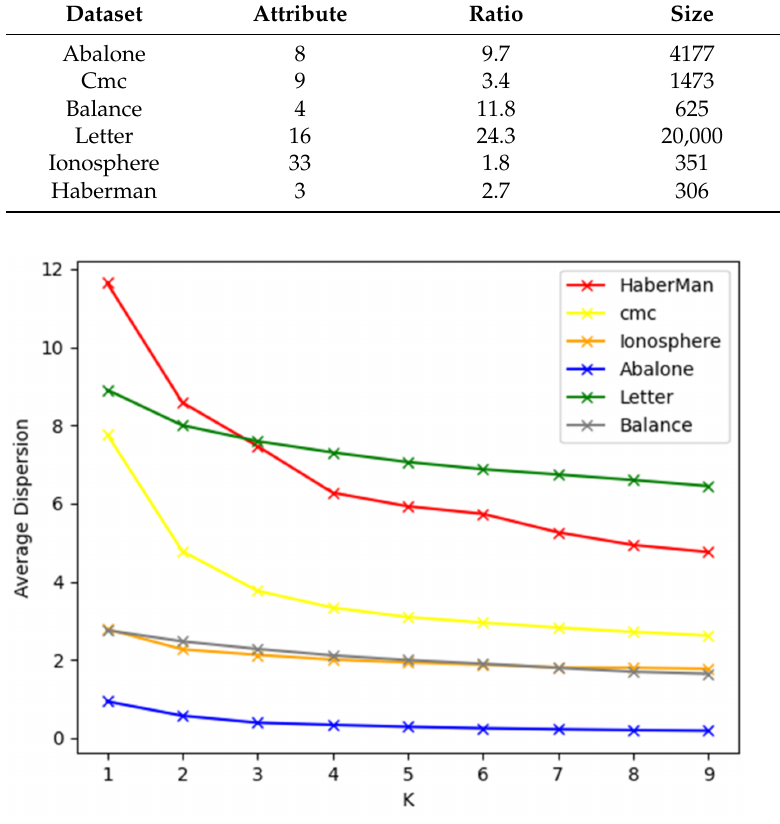
Figure 3. Selecting K via the elbow